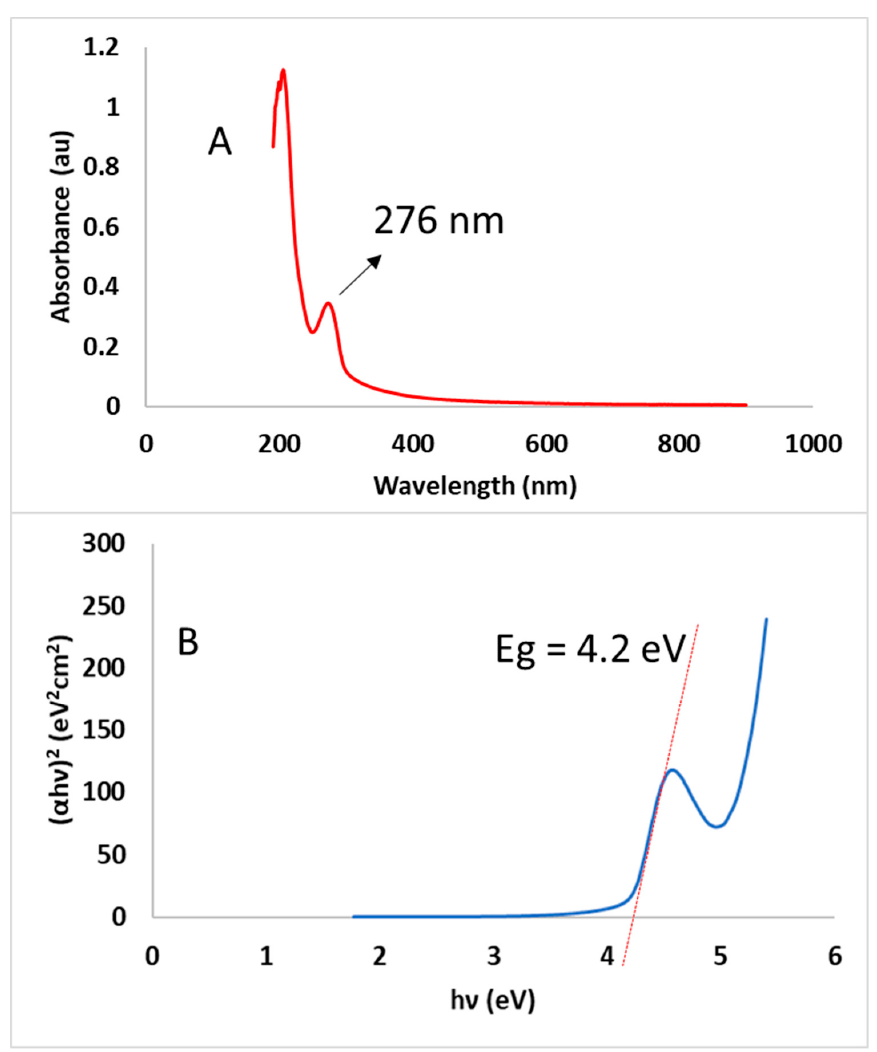
Figure 4. UV-Vis spectrum ( A ) and band gap energy ( B ) of SeNPs obtained under optimal conditions.